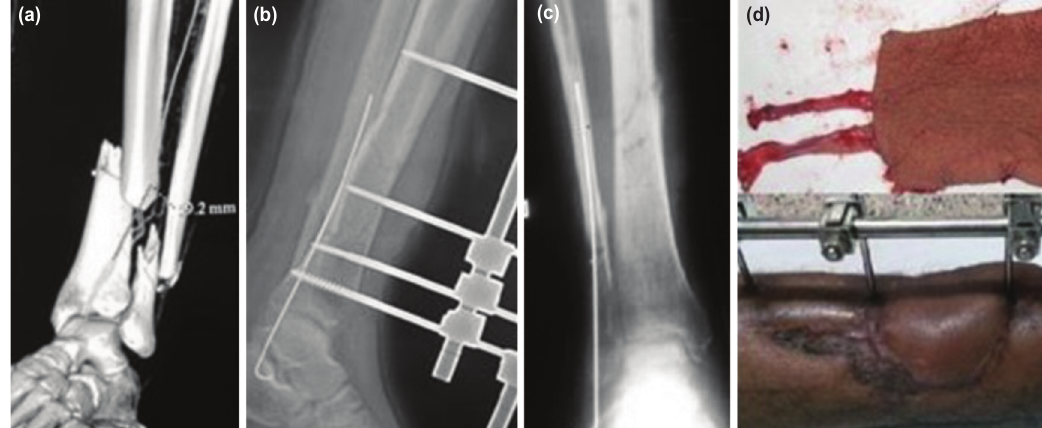
(a,b,c,d) Grade 3C open tibia fracture with ATA injury managed by external fixation, urgent vascular repair and radial artery Fig. 5: based forearm flap. Union was achieved with primary definitive external fixation with a single major surgical